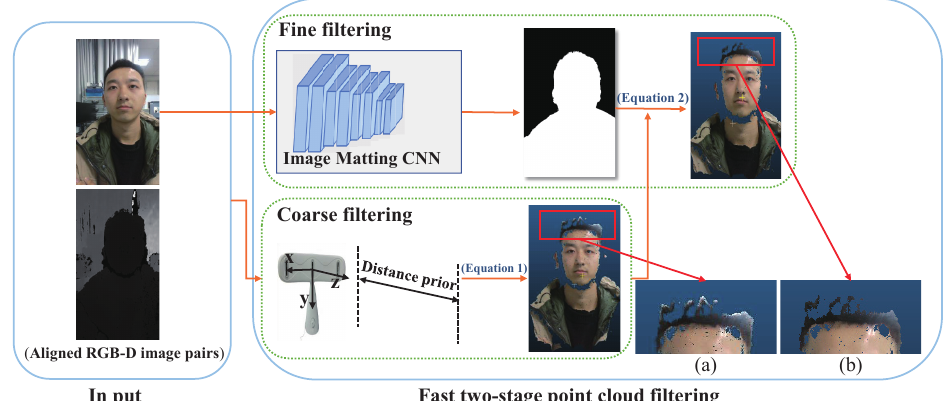
Figure 4. Schematic diagram of two-stage point cloud filtering. ( a ) Detailed image after coarse filtering. ( b ) Detailed image after fine filtering. It can be seen that the noise at the edges (curtains and lights in the background) of the hair is filtered out well after fine